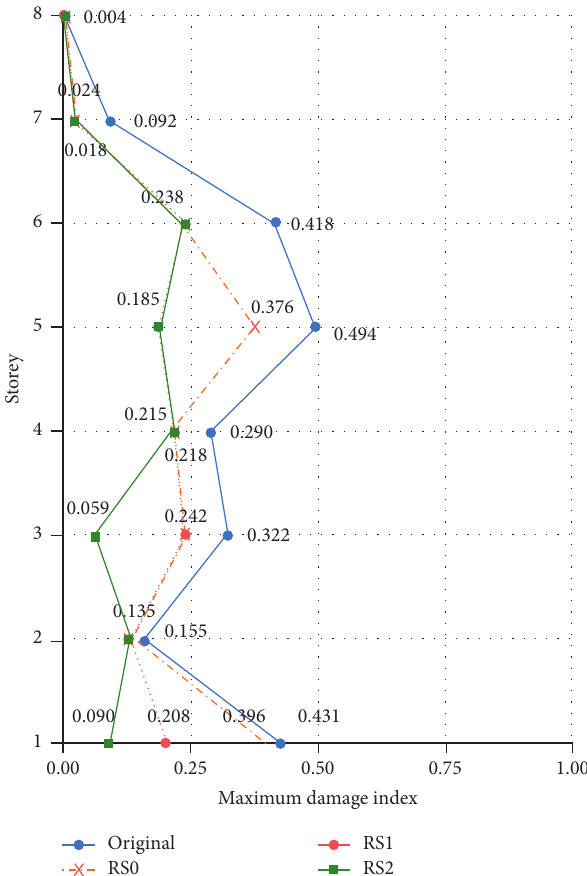
Figure 20: Distribution of storey damage of 8-storey frame.